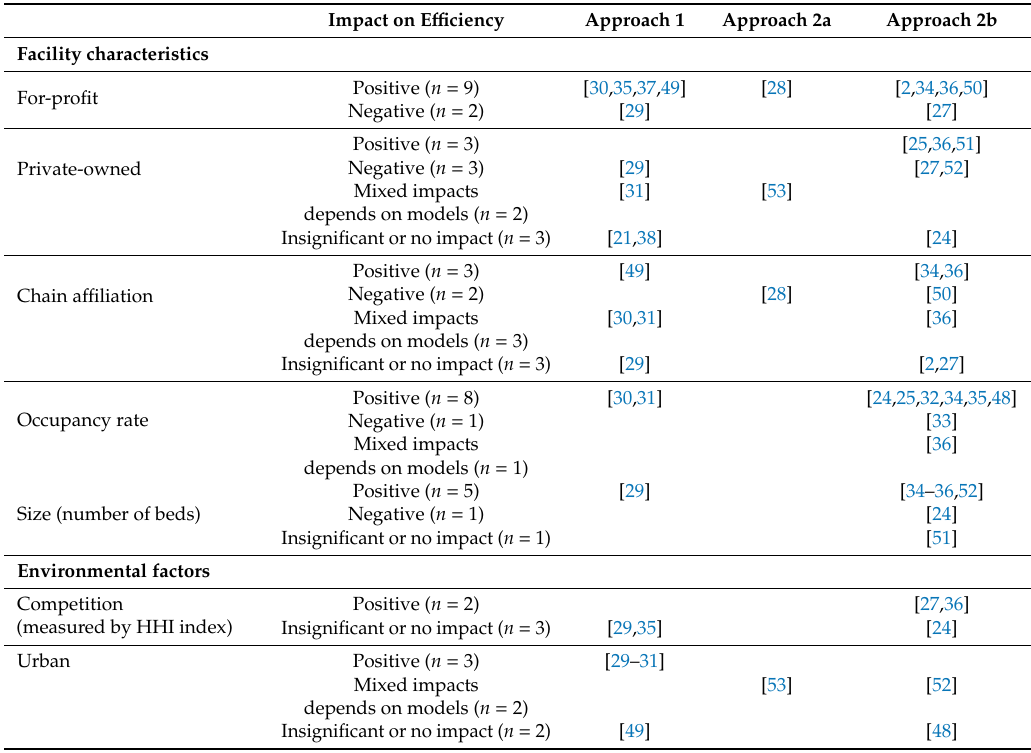
Table 3. Impacts on e ffi ciency and types of main control